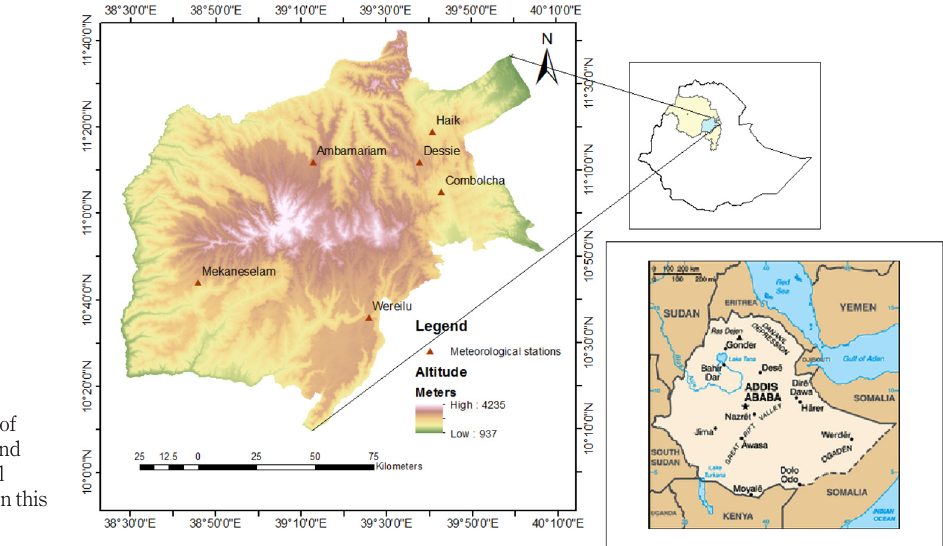
Figure 1. Location map